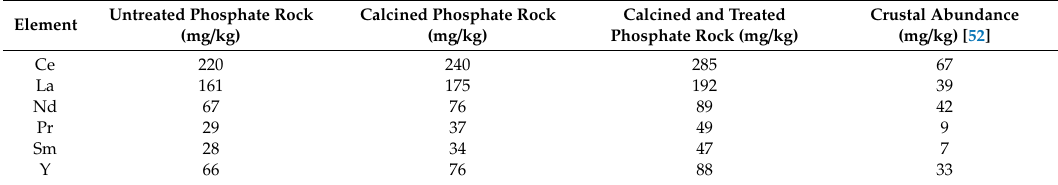
Table 4. Relevant Rare Earth Elements (REEs) in Untreated, Calcined, as Well as Calcined and Treated Sra Ouertane (Layer A1) Phosphate